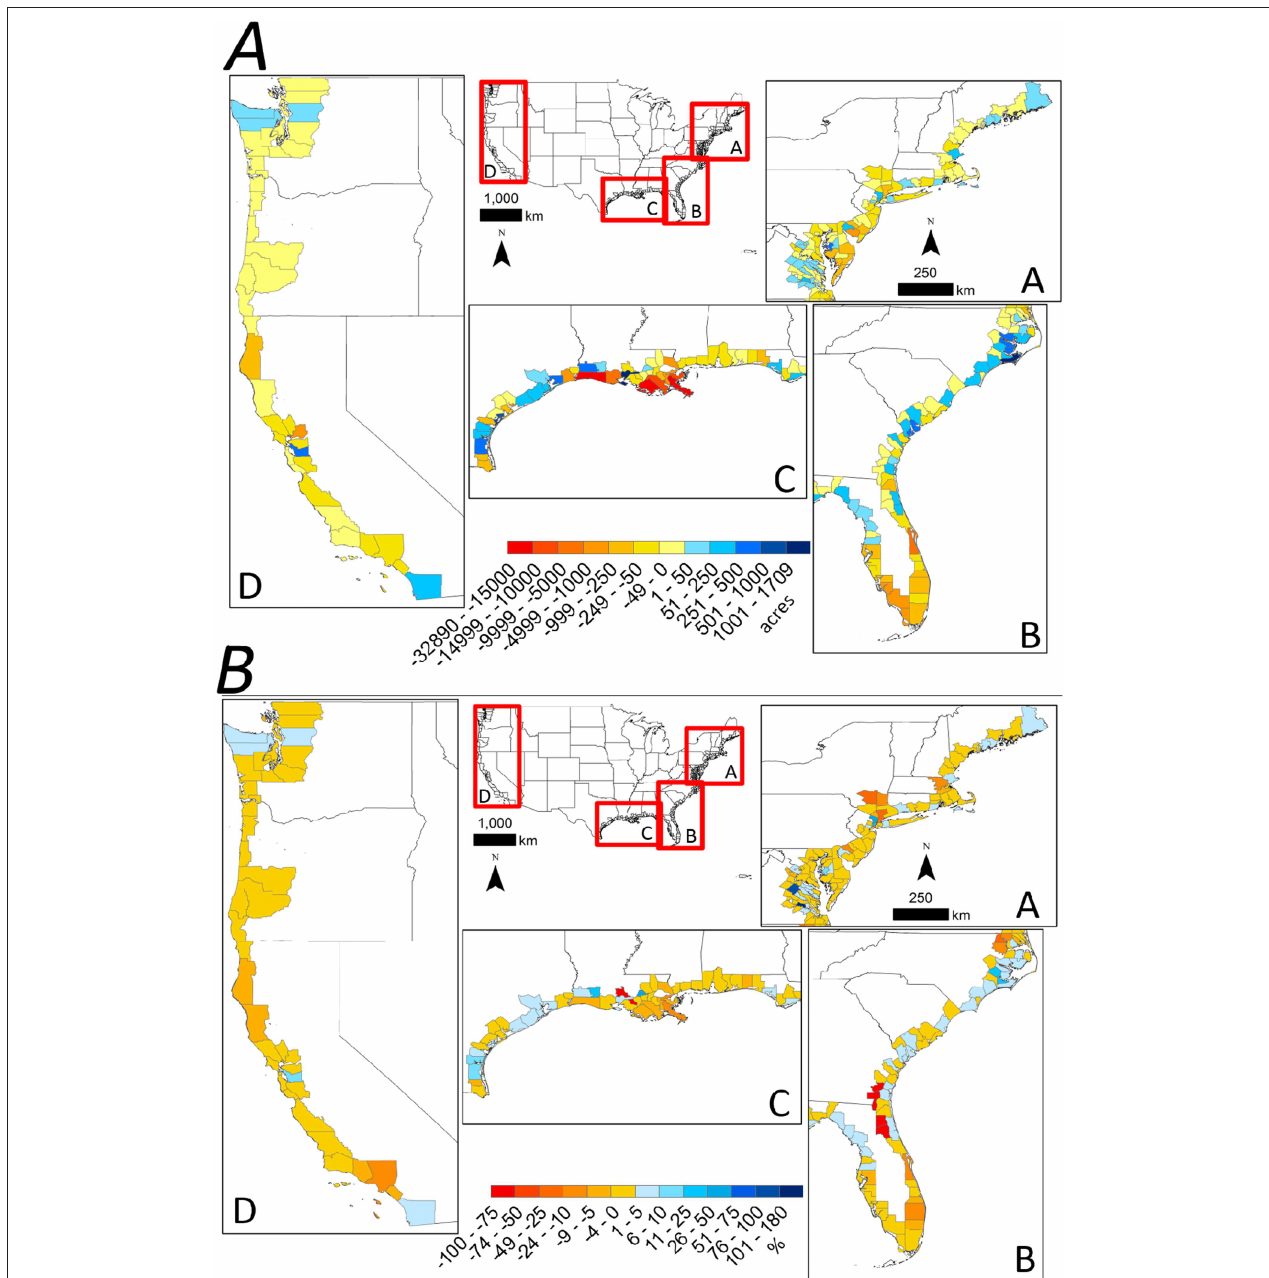
FIGURE 2 | National maps with inset panels showing coastal county-level variation in the (A) cumulative raw acreage change in estuarine wetlands from 1996 to 2010 and (B) cumulative percent change in estuarine wetlands acreage from 1996 to 2010 in the (A) Northeastern coastline, (B) Southeastern coastline and gulf coast of Florida, (C) Gulf of Mexico coastline, and (D) Pacific coastline of the conterminous United